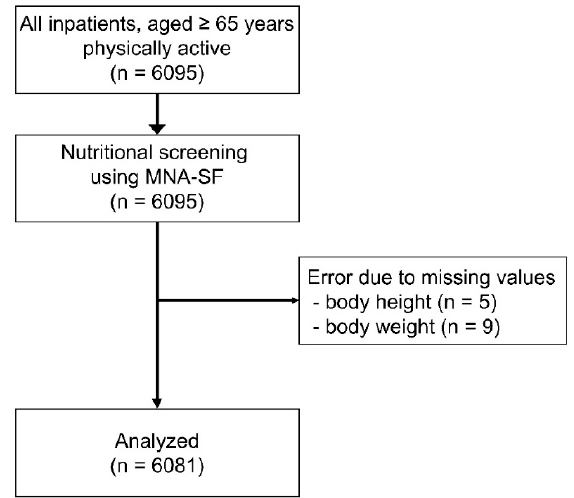
Figure 1. Flowchart of the study. Physically active and consecutive older adult patients ( n = 6095) were examined for participation eligibility. Eventually, 6081 patients were included in the study. Abbreviation: MNA-SF, Mini Nutritional Assessment Short Form.